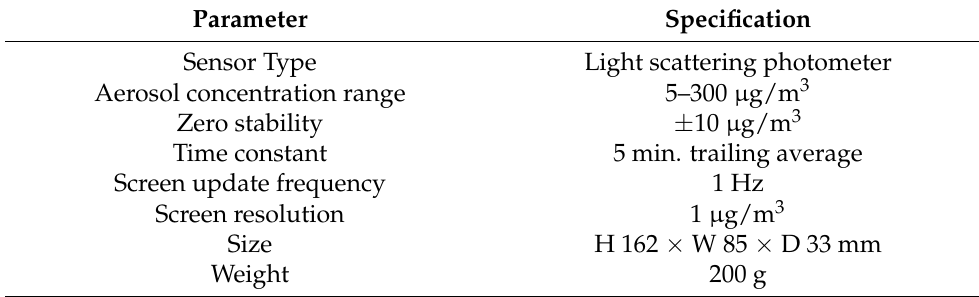
Table 9. Major specifications of IPM2.5-NA.